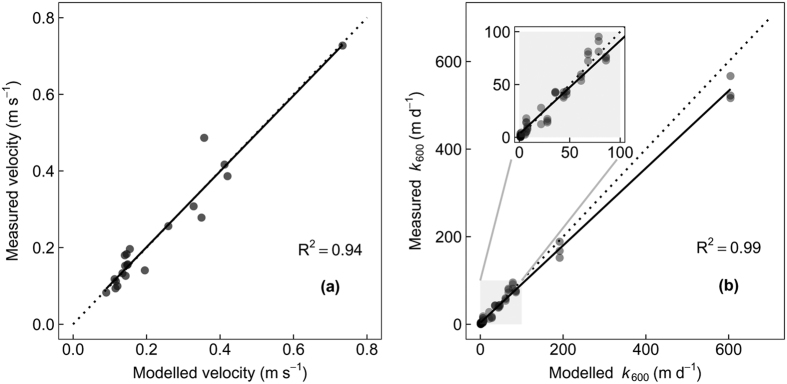
Scatter plots of modelled velocity (a) and k600 (b) against the corresponding measured values. All p values were < 0.001. The insets in panel (b) shows the fit in the lower range of k600. The modelled k600 was multiplied by a factor of 0.89 to avoid overestimates in higher ranges of modelled values (see text). Darker symbol colour indicates data point overlaps.